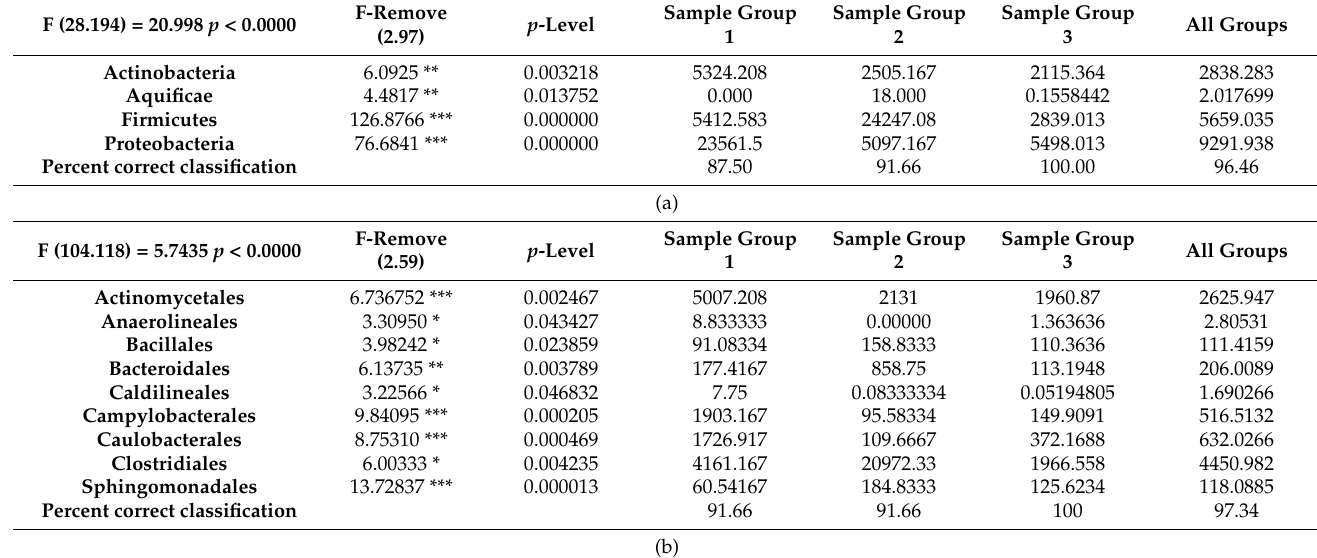
Table 5. Discriminant analysis values for significant bacteria at phylum ( a ) and order ( b ) level and according group of sample classification (* = p < 0.05; ** = p < 0.01; *** = p < 0.001). F-Remove F (28.194) = 20.998 p < 0.0000 (2.97)